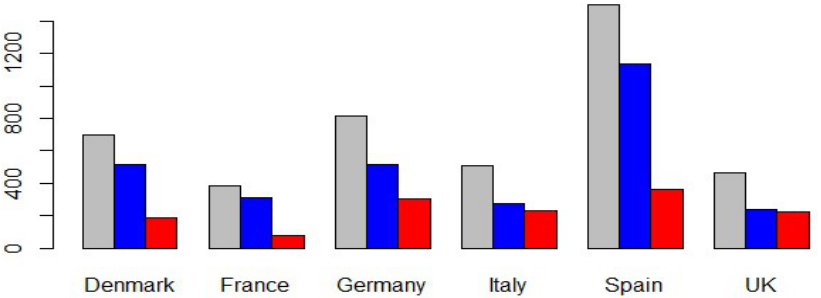
Figure 4. Total number of outliers in each country (total in gray, downward in blue, upward in